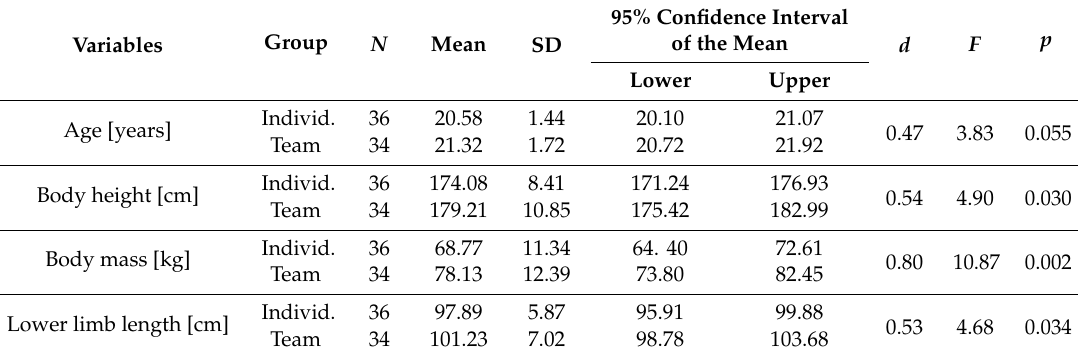
Table 2. Change-of-direction speed (CODS) and reactive agility (RA) performance in the frontal (FR), universal (UN), semi-circular (SC), and lateral (LA) configurations and between-group comparisons. Variables Group N Mean SD Individ. FR-CODS [s] Individ. FR-RA [s] Individ. UN-CODS [s] Individ. UN-RA [s] Individ. SC-CODS [s] Individ. SC-RA [s] LA-CODS [s] LA-RA [s]